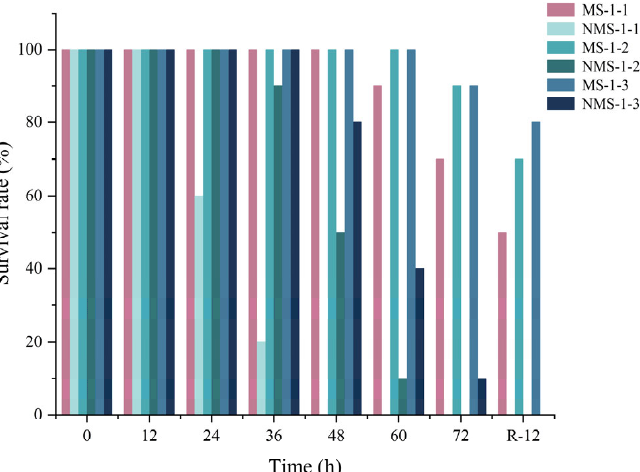
Figure 2. The survival rate of sea bass in treatment samples and basal samples during and after transport. MS ‐ 1 ‐ 1: 30 mg/L MS ‐ 222, fish to water ratio was 1:1; NMS ‐ 1 ‐ 1; fish to water ratio was 1:1; MS ‐ 1 ‐ 2: 30 mg/L MS ‐ 222, fish to water ratio was 1:2; NMS ‐ 1 ‐ 2: fish to water ratio was 1:2; MS ‐ 1 ‐ 3: 30 mg/L MS ‐ 222, fish to water ratio was 1:3.; NMS ‐ 1 ‐ 3: fish to water ratio was 1:3.